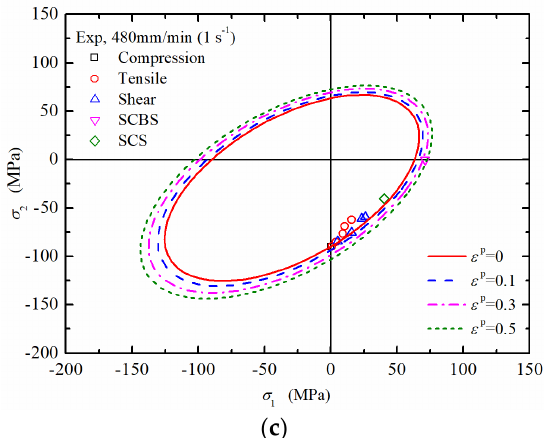
Figure 6. Mechanical response of PA66 under complex stress state: ( a ) material constants of the Drucker Prager yield criterion; ( b ) yield criterion of PA66 at different strain rates; ( c ) subsequent yield criterion of PA66.